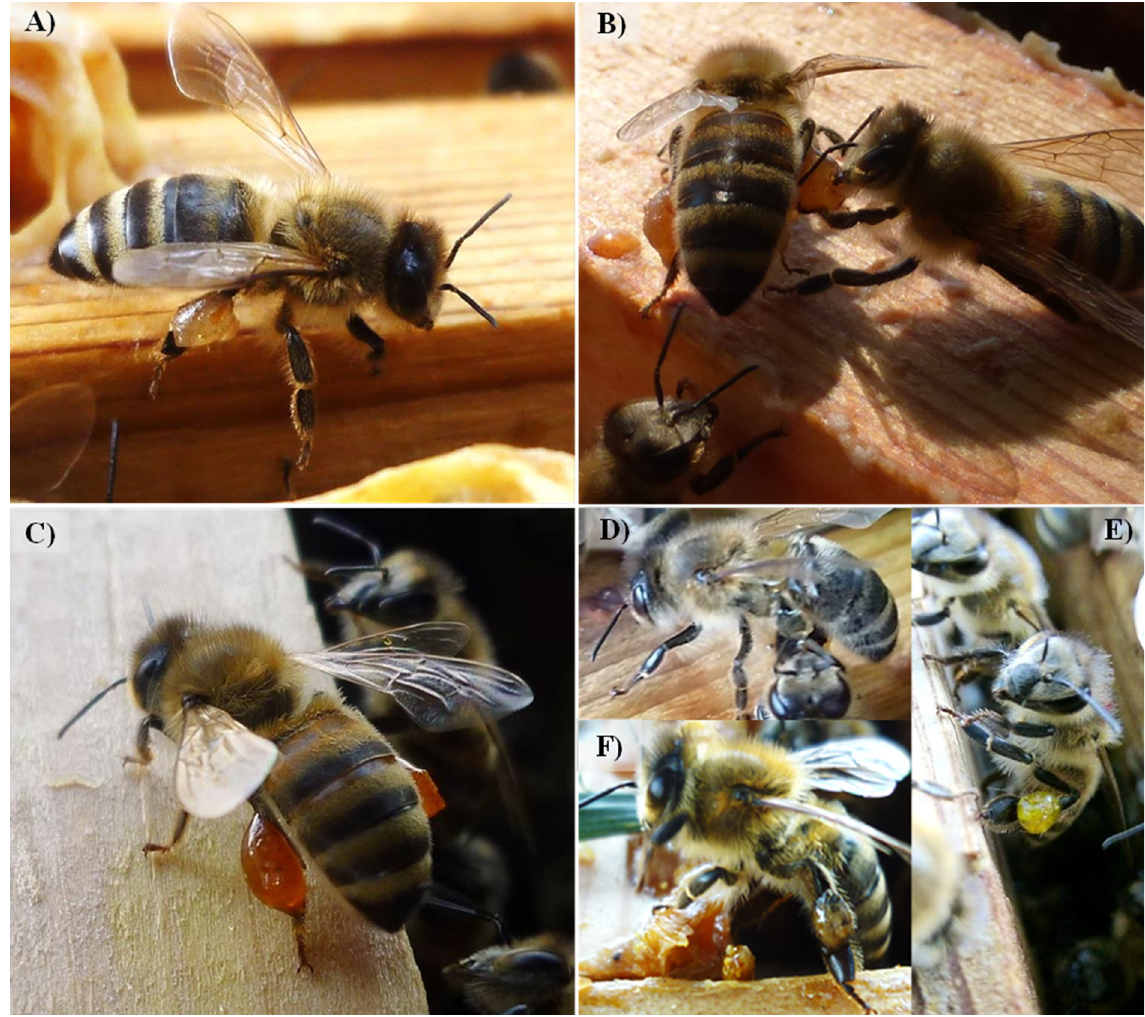
Fig 1. Resin foragers carrying different resin types on their hind legs. Different resin (color-) types (A-F) were used for visual determination of different resin types: A) “ocher”, B-C)”orange”, D) “clear”, E) “yellow”, F) “brown”.